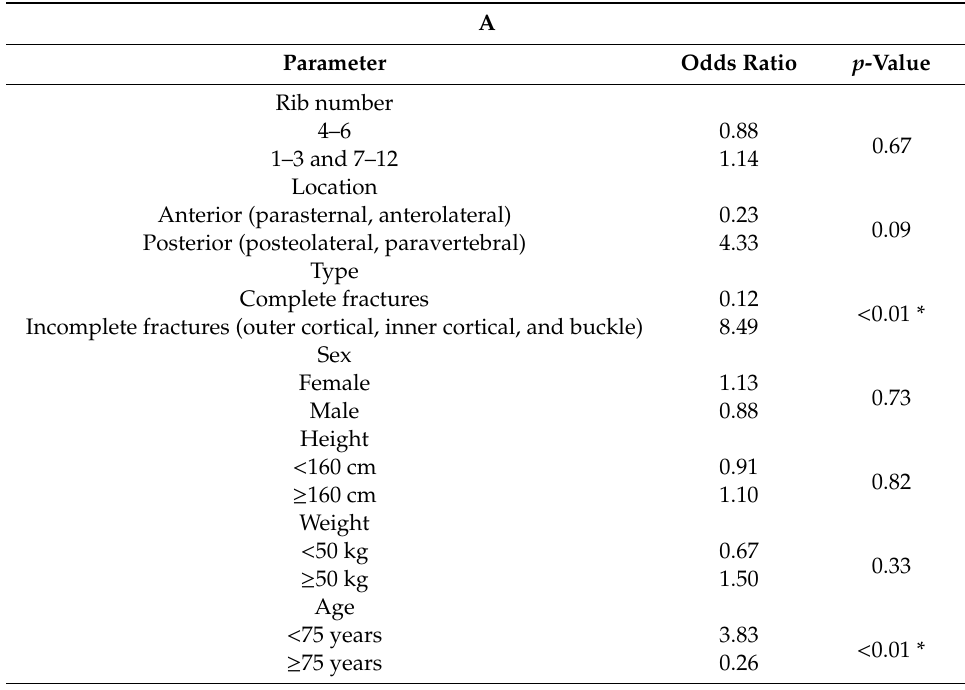
Table 4. ( A ). Logistic regression model for findings negative on autopsy but positive on PMCT. ( B ). Logistic regression model for findings negative on PMCT but positive on